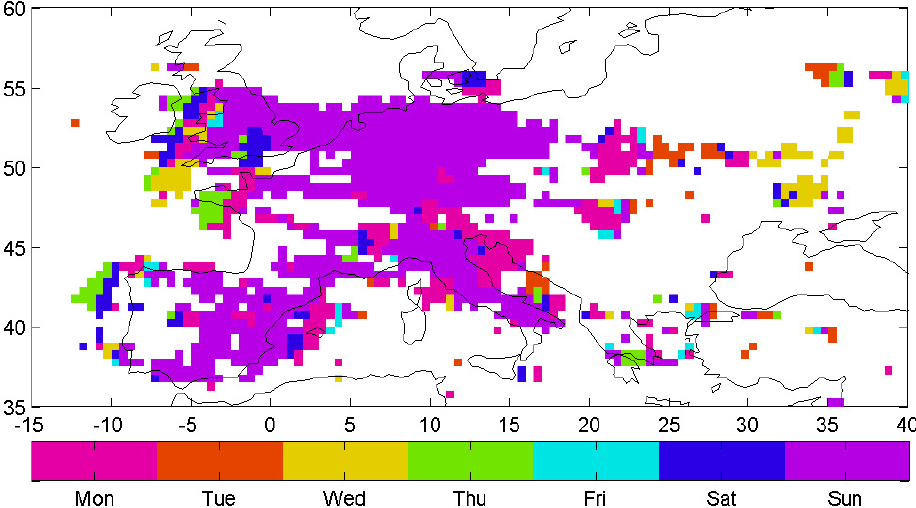
Fig. 8. Day of week with minimum TVCD (see Fig. 6b) for Europe. Over most regions, the minimum occurs on Sunday. In eastern Europe the minimum is shifted to the beginning of the week indicating the transport of the temporal emission patterns of the strong western NO x sources with the dominating westerly winds. Only data of p-values less than 0.001 are shown. Colors coded as in Fig.